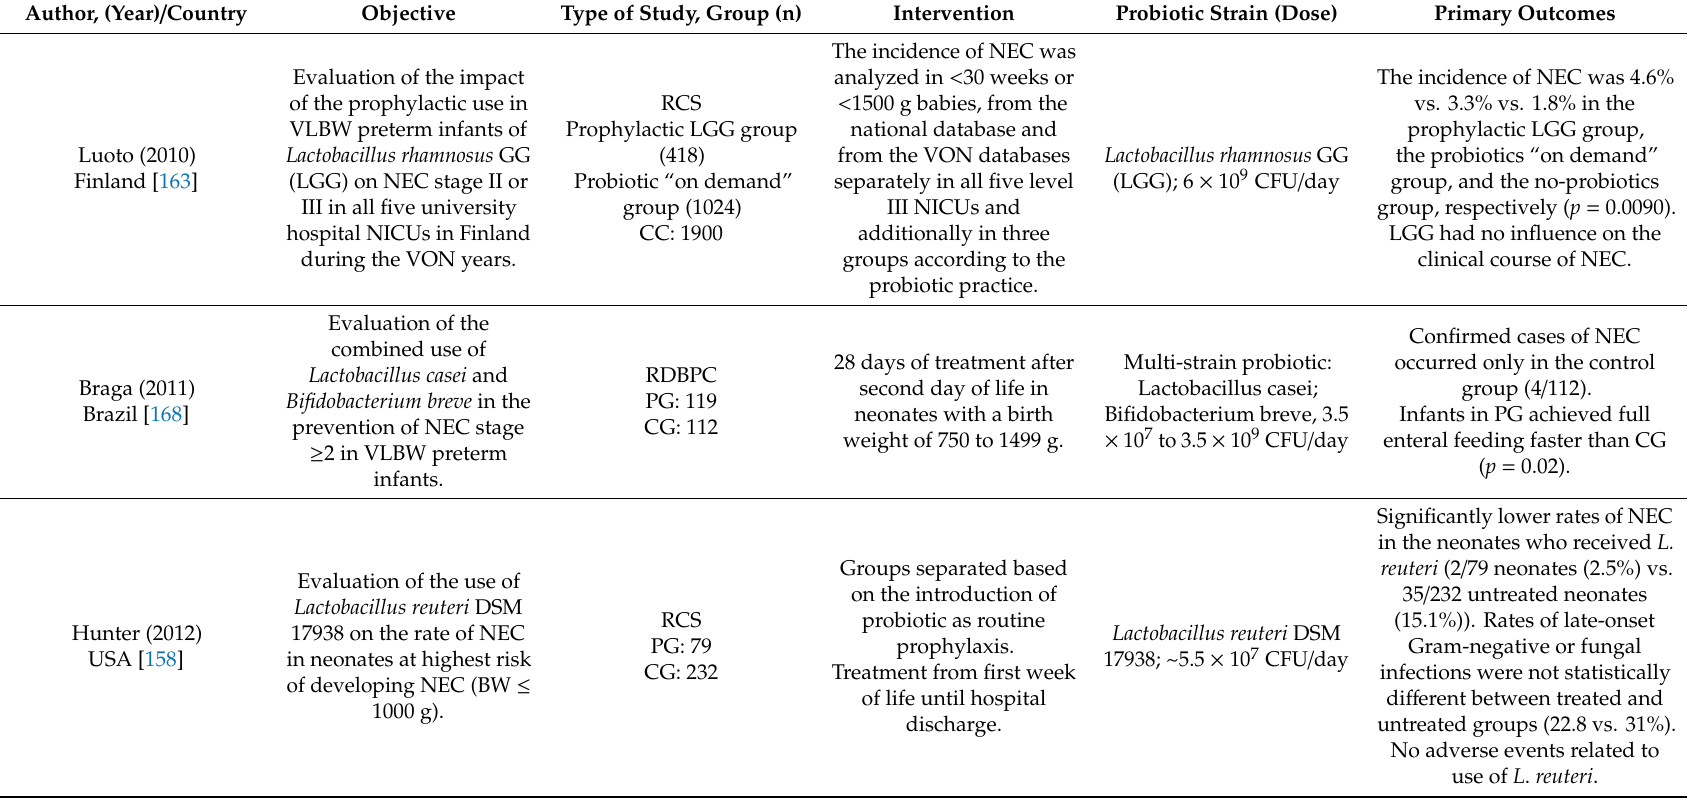
Table 6. Main findings of studies related to the use of probiotics in preterm